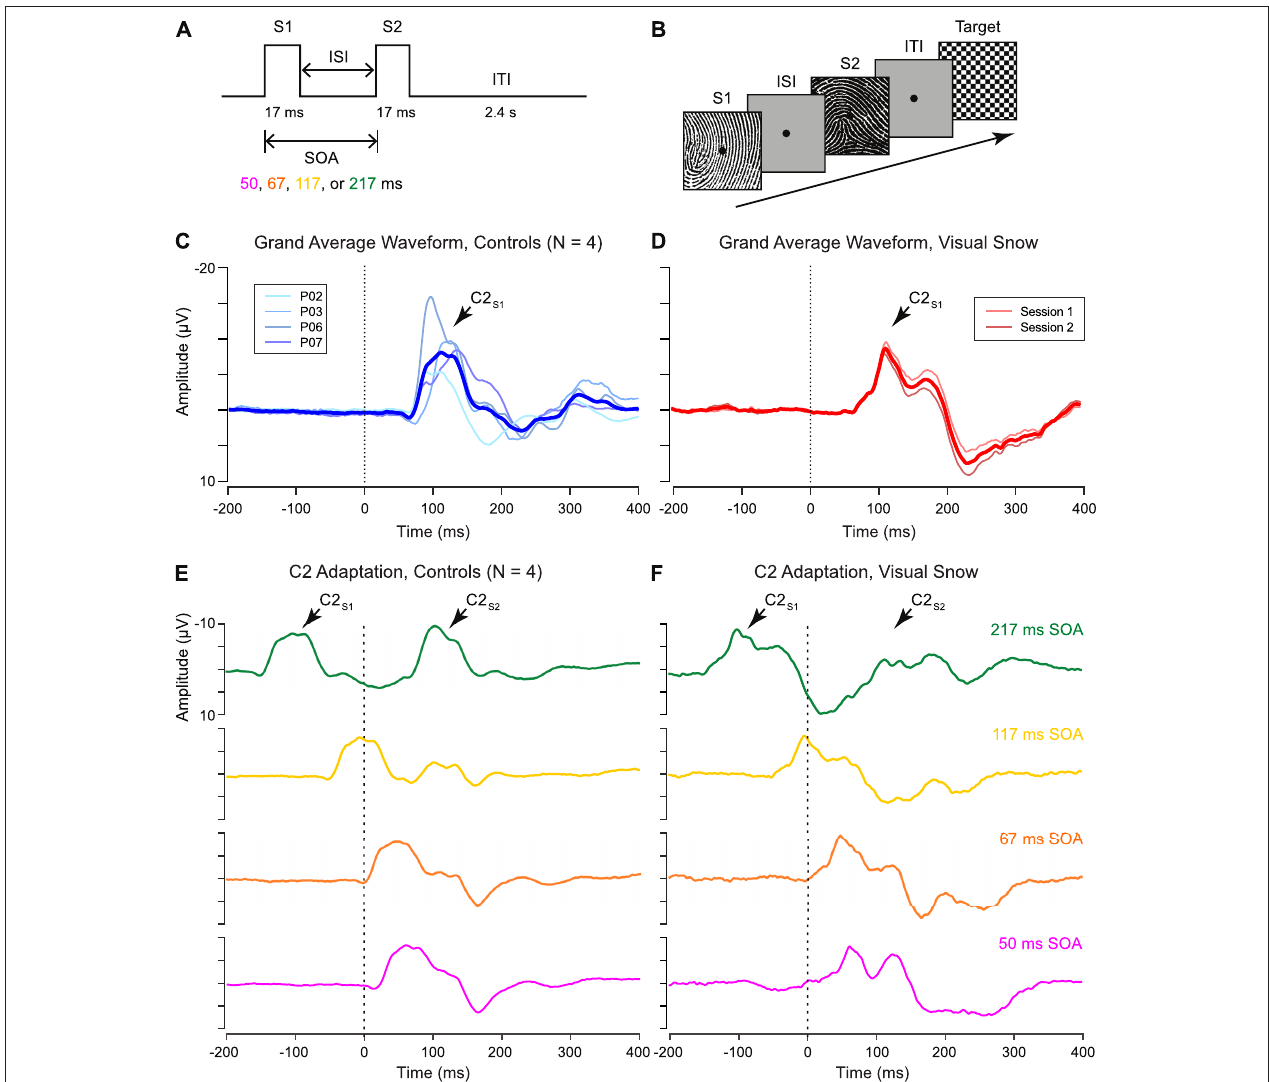
FIGURE 1 | (A) Schematic of “double-pulse” presentation paradigm. Two stimuli (S1 and S2) are presented with a variable interstimulus interval (ISI), resulting in a stimulus onset asynchrony (SOA) of 50, 67, 117, or 217ms. After the S2 stimulus, an intertrial interval (ITI) of 2.4s was selected to minimize persistent afterimages in the visual snow patient. (B) Sample trial structure. On each trial, a high-contrast stimulus was selected to serve as S2, paired with a randomly selected non-identical image as S1. Participants monitored for the appearance of an infrequent target (checkerboard pattern), which occurred on 10% of trials. (C,D) Grand average waveform for C2 response in (C) controls and (D) visual snow patient, as identified from the unadapted S1 condition. (E,F) Adaptation of the C2 response in (E) controls and (F) visual snow patient for each tested SOA (green: 217ms, gold: 117ms, orange: 67ms, fuschia: 50ms). Grand average waveforms are time-locked to the onset of the S2 stimulus (dotted line, 0ms), with the C2 response visible ∼ 100ms after stimulus onset. Grand averages in (F) reflect the average of two separate sessions in the visual snow